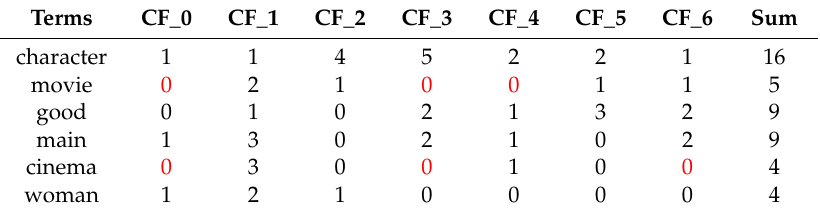
Table 5. Fragment of the Absolute Frequency Terms-CF Matrix.